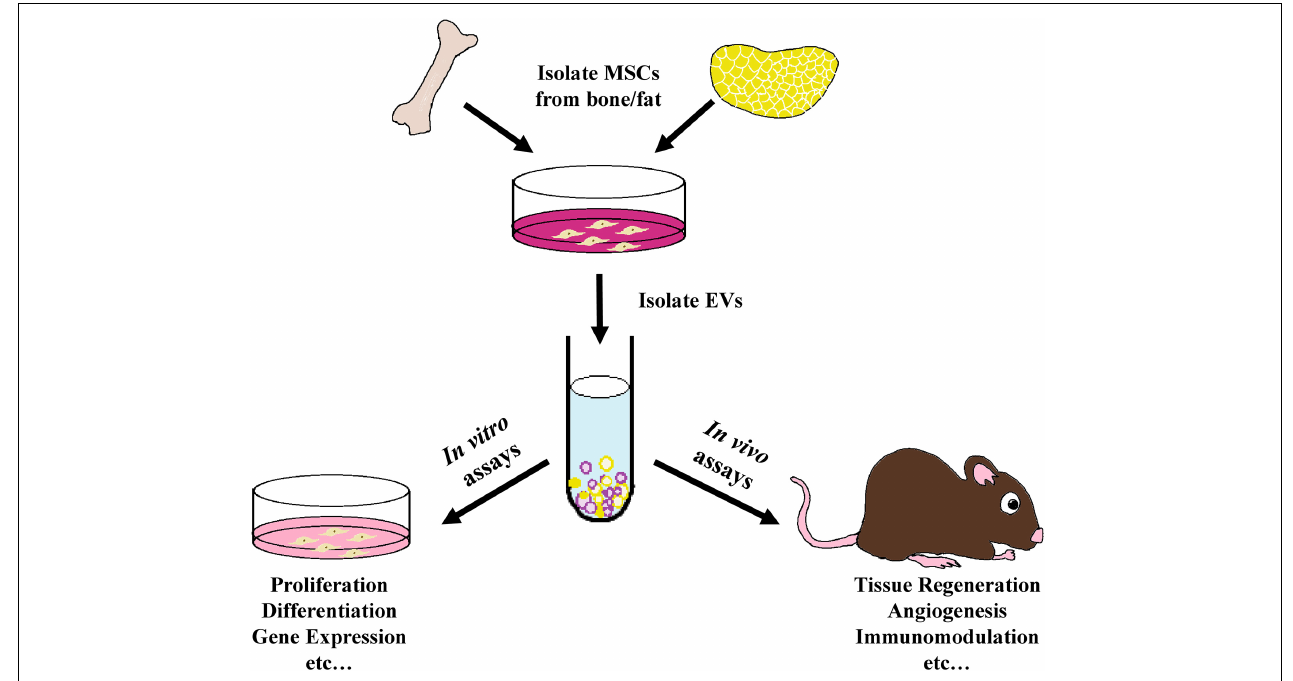
FIGURE 1 | Schematic outline of the use of MSC- derived EVs within tissue regeneration models as analyzed in this review. EVs were isolated from the culture media of bone marrow-derived or adipose-derived MSCs and employed in various in vitro proliferation, differentiation, gene expression, and other assays, as well as within a variety of in vivo tissue regeneration studies, including preclinical animal models and human clinical trials.